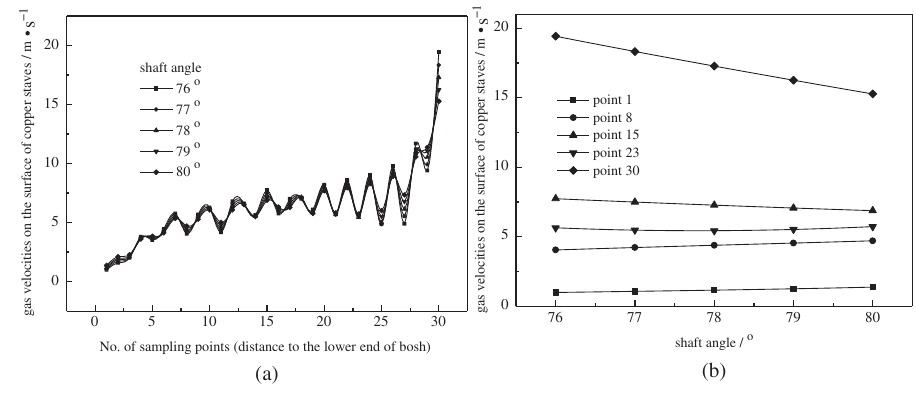
Figure 6: The gas flow velocities at the shaft area after “ rectify- ing effect ” under the conditions of different shaft angles.